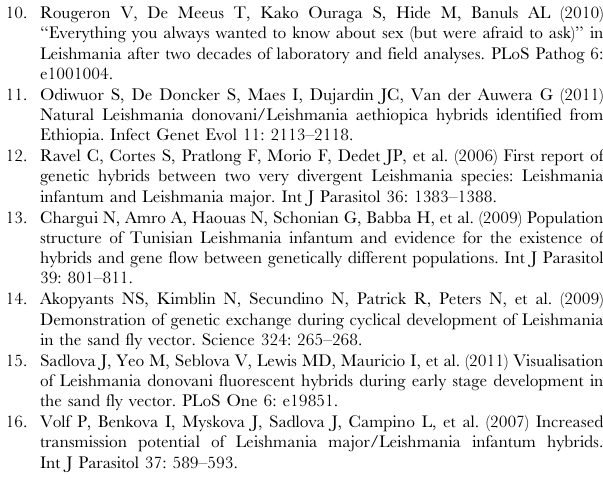
blocks scaled from low (blue) to high (beige) LD for each pair of blocks on the same chromosome, for each chromosome in the L. infantum genome. Figure S14 Decay of linkage equilibrium between SNP pairs with distance for each chromosome. Linkage disequilibrium (LD) decay with distance for the entire chromosome. The LD (r 2 between SNP pairs, y-axis) is on the inset (ranging from 0 to 1). The distance (x-axis) is shown in units of 10 kb. LD decay varied considerably between chromosomes. Bottom: Diversity at each chromosome region shown in 10 kb blocks for the fixed SNPs per kb compared to L. infantum JPCM5 (red), those relative to L. donovani BPK282/0cl4 (blue), the nucleotide diversity ( p ) per 10 kb for variation within the CUK population (green), and the summary statistic Tajima’s D. Note the difference scale for p compared to the fixed SNPs. Tajima’s D compares the level of intermediate- and low-frequency variants; here positive D values tended to occur at possible recombination blocks. Figure S15 Variation in allele frequencies for heterozygous sites on multisomic CUK chromosomes. Analyses are shown for Chromosomes 4,6,15,22–25,31–33. Shifts in allele frequencies from 0.33 to 0.66 on trisomic chromosomes or 0.25 to 0.75 or 0.5 on tetrasomic chromosomes underscore recombination sites. Figure S16 Regression model estimates of mutation rate and recombination rate in Leishmania infantum . (A) Recombination rate and (B) mutation rate both show a consistent relationship with genome size across eukaryotic species. (A) Points show data for eukaryotic species from [55]; (B) Points show data from [56]. In both panels, the solid line represents the predicted relationship based on a log-log regression model, with dark and light shading represent 95% and 99% prediction intervals, respectively. Dashed line indicates the intercept for Leshmania infantum , with an estimated genome size of 32.8 Mb. Figure S17 Detailed results of the mixture model analysis. (A) Counts of heterozygous and homozygous SNPs in non-overlap- ping 5 kb windows along the genomes of 12 CUK strains (points), assigned to three classes (point colours) by maximum posterior probability of cluster membership under the 3-component 2- dimensional Poisson mixture model. Ellipses represent density of